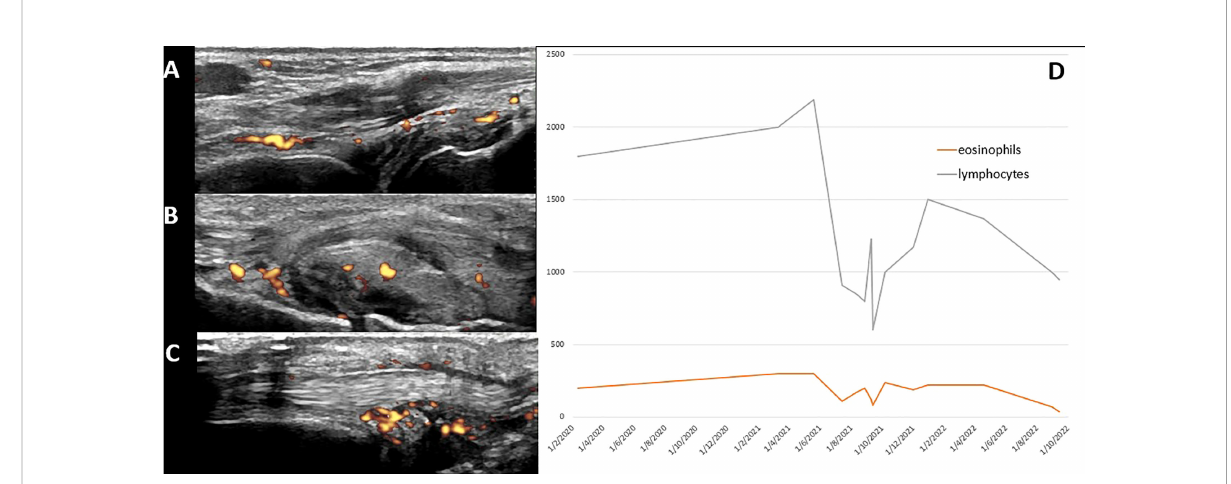
FIGURE 2 Diagnosis workup: ultrasound imaging ( A : synovitis of the right wrist; B : synovitis of the right calcaneocuboid joint; C : tenosynovitis of the left extensor carpi ulnaris) and (D) plotting of blood